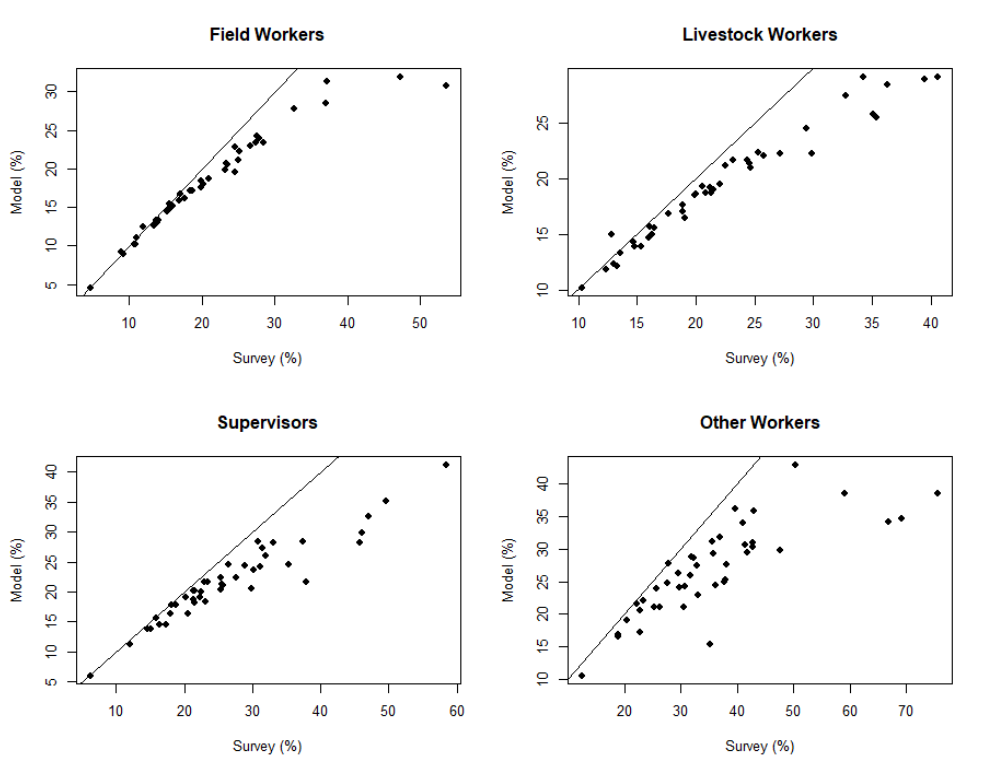
Figure 9. Coefficients of variation (%) for state-level model and survey estimates of number of workers by worker